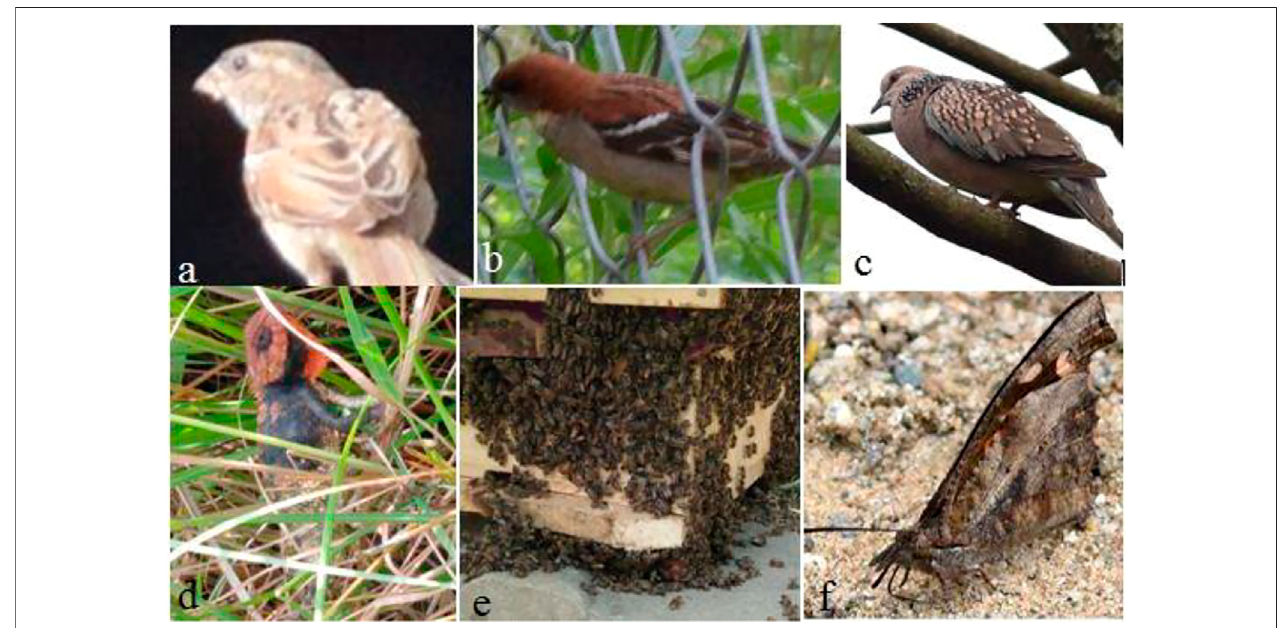
FIGURE 2 | Statistically signi fi cantly important pictures ( (A) house sparrow; (B) Russet sparrow; (C) spotted dove; (D) oriental garden lizard; (E) honey bee; (F) common beak) from study areas.